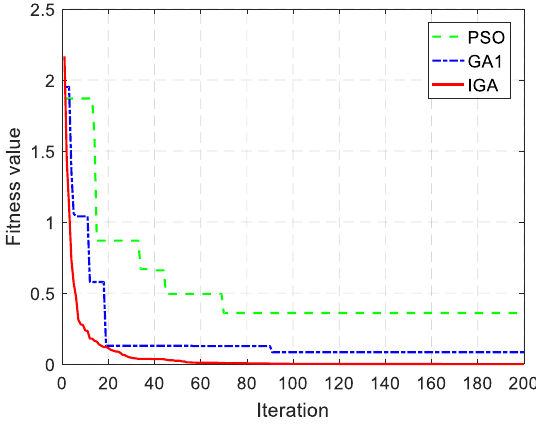
Figure 10. Parameter identification process. Table 2. Electric rudder system identification results.